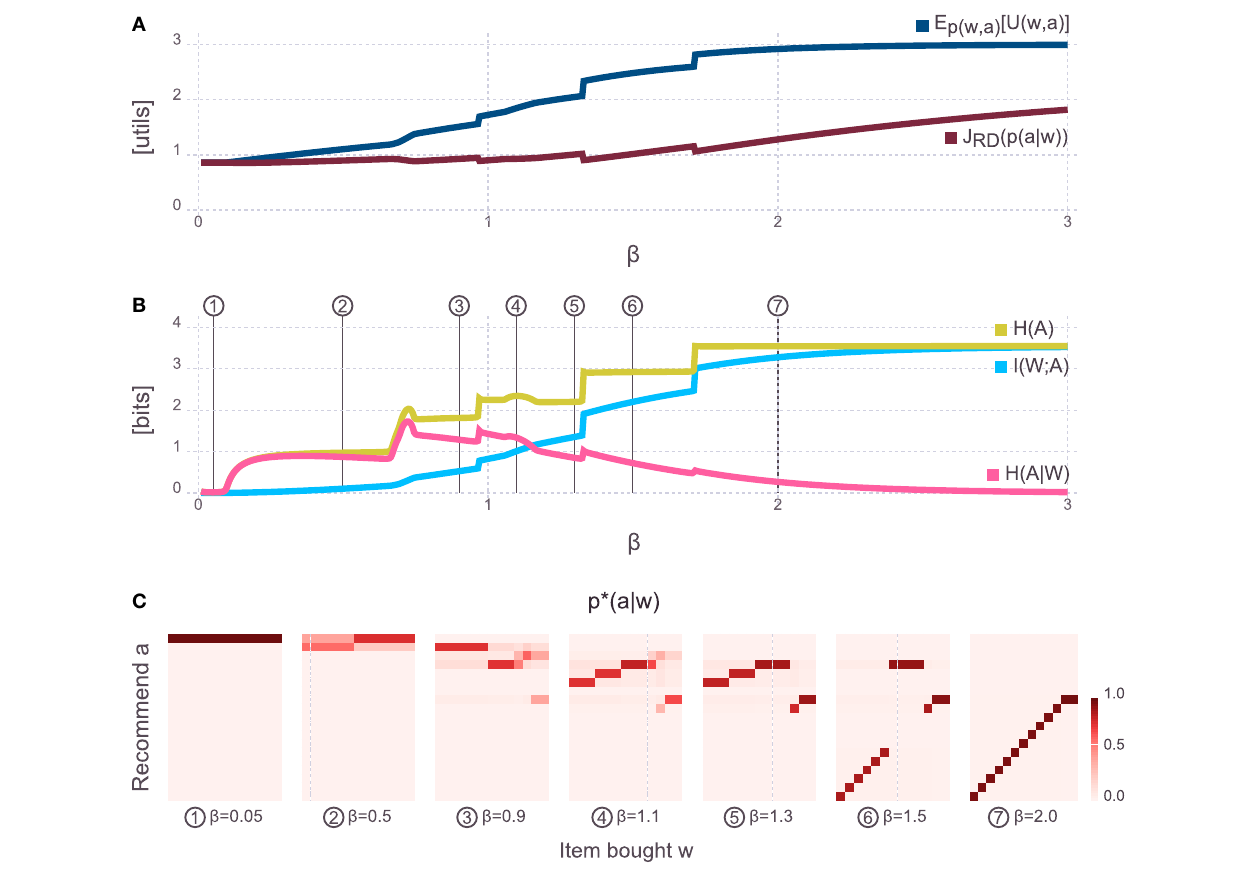
FIGURE 3 | Sweep over (cid:12)(cid:12)(cid:12) values . (A) Evolution of expected utility and value of the objective J RD ( p ( a | w )) [equation (7)]. The expected utility is monotonically increasing, the objective also increases with increasing (cid:12) but not monotonically. In both curves, there are some sharp kinks which indicate a change in level of abstraction (see panels below). (B) Evolution of information quantities. The same sharp kinks as in the panel above can also be seen in all three curves. Interestingly, H ( A ) has mostly flat plateaus in between these kinks which means that the behavior of the agent does not change qualitatively along the plateau. At the same time, H ( A | W ) goes down, indicating that behavior becomes less and less stochastic until a phase transition occurs where H ( A ) changes. (C) Solutions p *( a | w ) [equation (9)] that illustrate the agents behavior on each of the plateaus of H ( A ). It can be seen that on each plateau (and with each kink), the level of abstraction